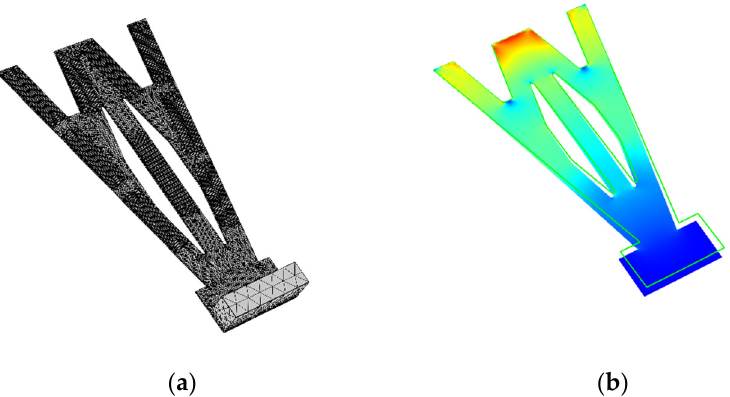
Figure 2. ( a ) meshes of the STTM-PEH; ( b ) stress distribution of T-shaped trapezoidal piezoelectric cantilever beam.